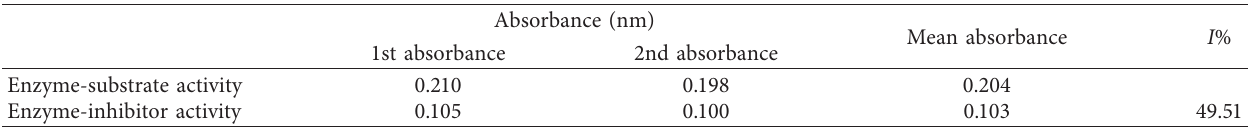
Table 2: Inhibitory activity of cinnamon bark oil on PPO activity of the Musa acuminata extract.